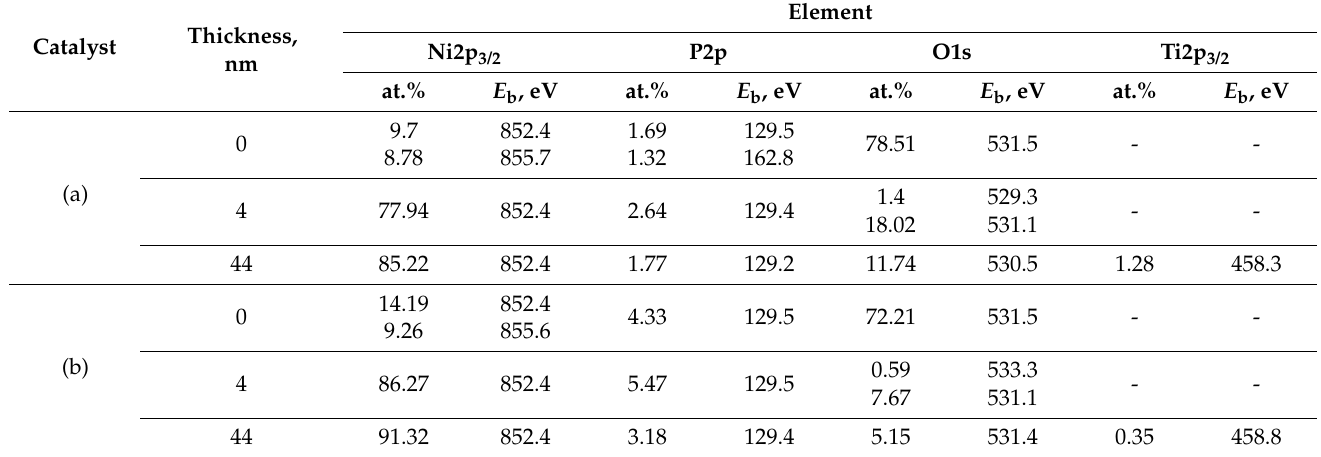
Table 3. The surface composition of the Ni-TiO 2 ntb catalysts was determined by XPS analysis. The Ni-TiO 2 ntb electrodes were prepared by dipping TiO 2 ntb electrodes in the Ni plating bath at 85 ◦ C for (a) 20 and (b) 60